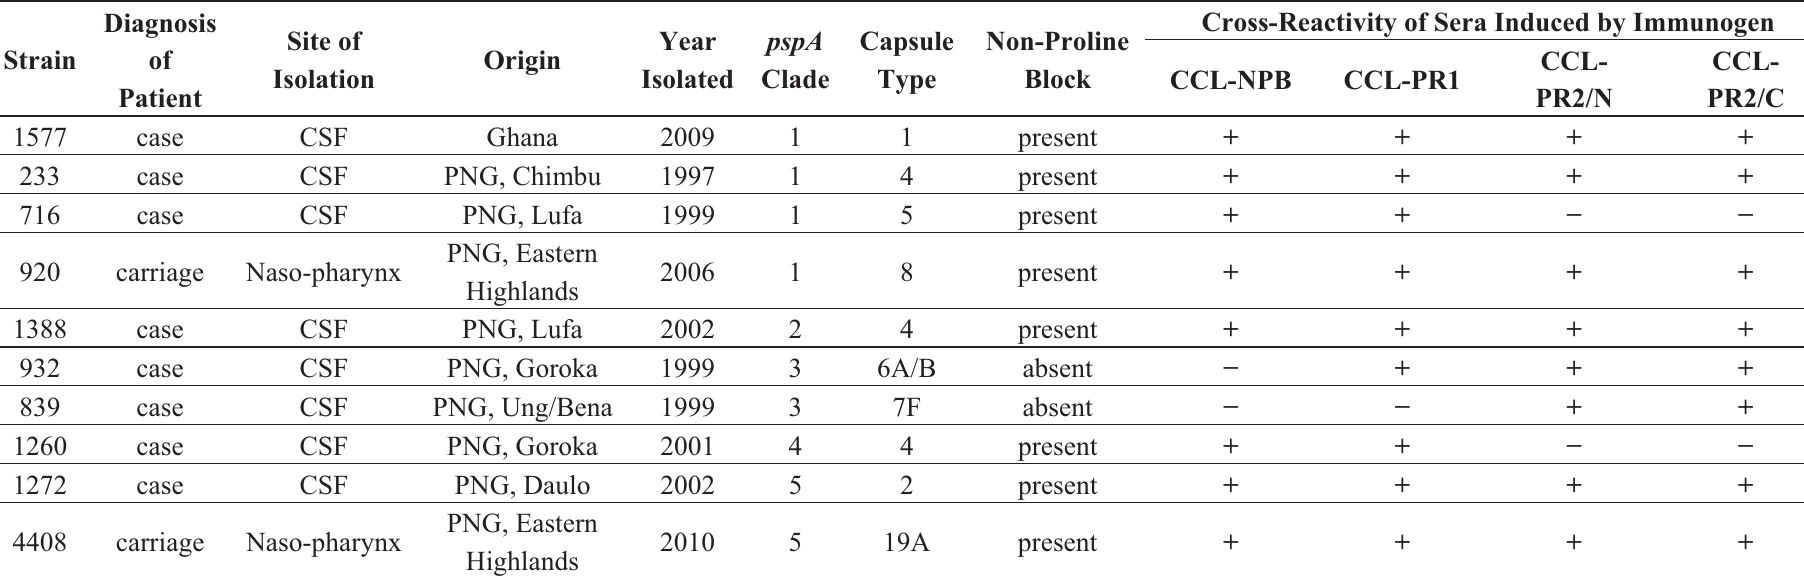
Table 1. Cross-reactivity of immune-sera with genetically diverse pneumococcal clinical isolates in flow-cytometric analyses. Capsular serotypes and pspA allelic variants that have been classified into clades according to [30] are shown. (+ = surface staining; (cid:3) = no surface staining). A maximum likelihood phylogenetic tree of the PRR sequences of the 10 tested S. pneumoniae clinical isolates and of 44 S. pneumoniae genomes from the NCBI database is shown in the Appendix (Figure A2). CSF = Cerebrospinal